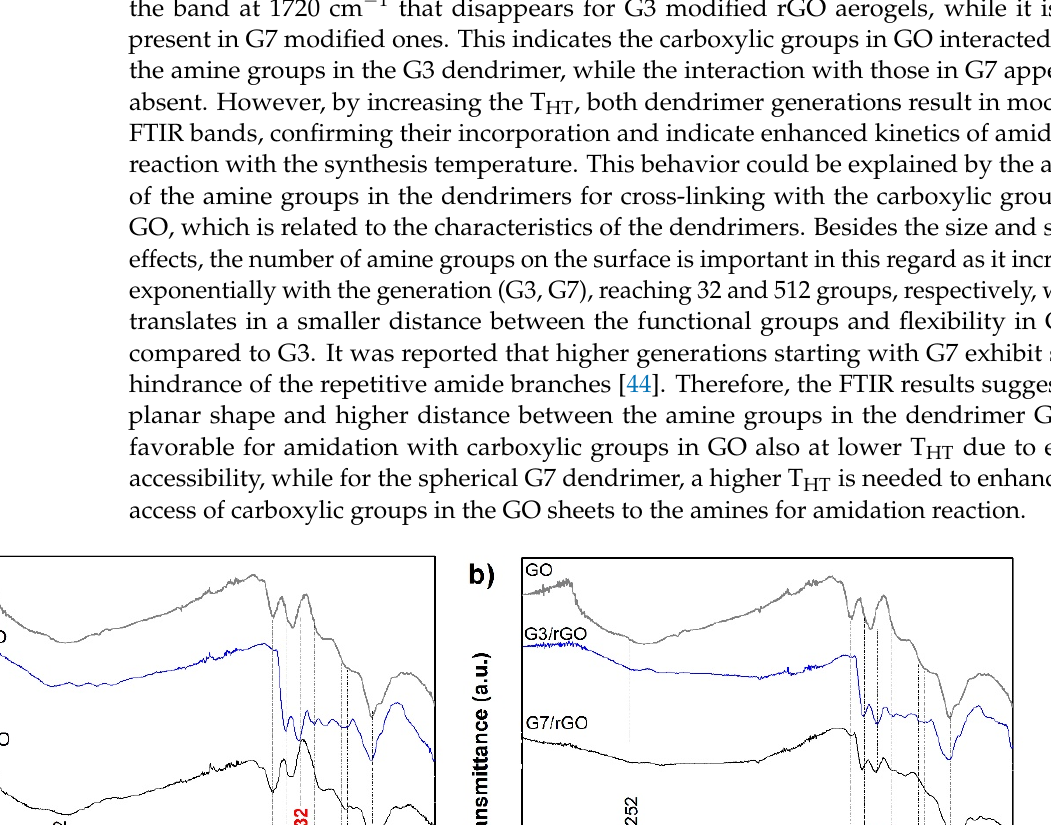
Table 1. Chemical composition wt.% by XPS measurements and elemental analysis. (sample nota-